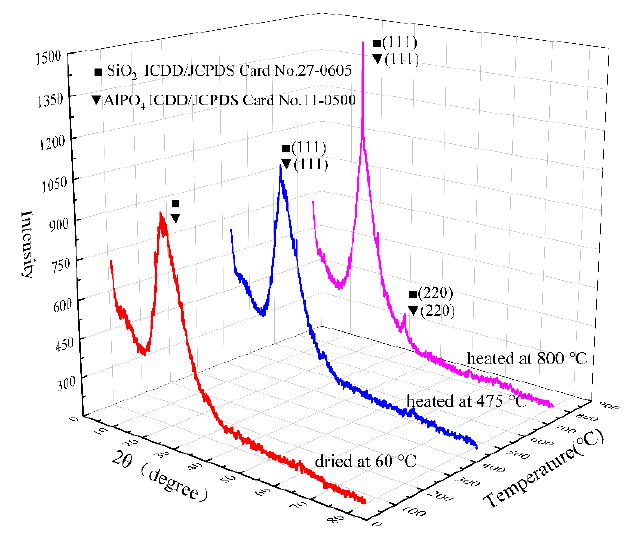
Figure 2. The XRD patterns of the coatings after different heat treatment.